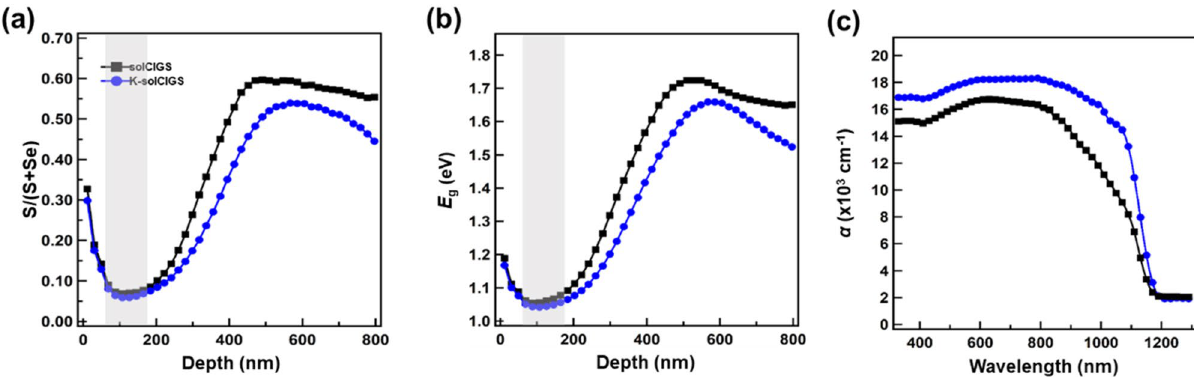
Figure 1. ( a ) Relative elemental ratio of S/(S + Se) and ( b ) bandgap energy of solCIGS and K-solCIGS thin films; modified with permission from ref 14, Copyright 2020, WILEY–VCH. The gray colored areas show the minimum bandgap ( E g,min ) region. ( c ) Optical absorption coefficient ( α ) spectra of solCIGS and K-solCIGS thin